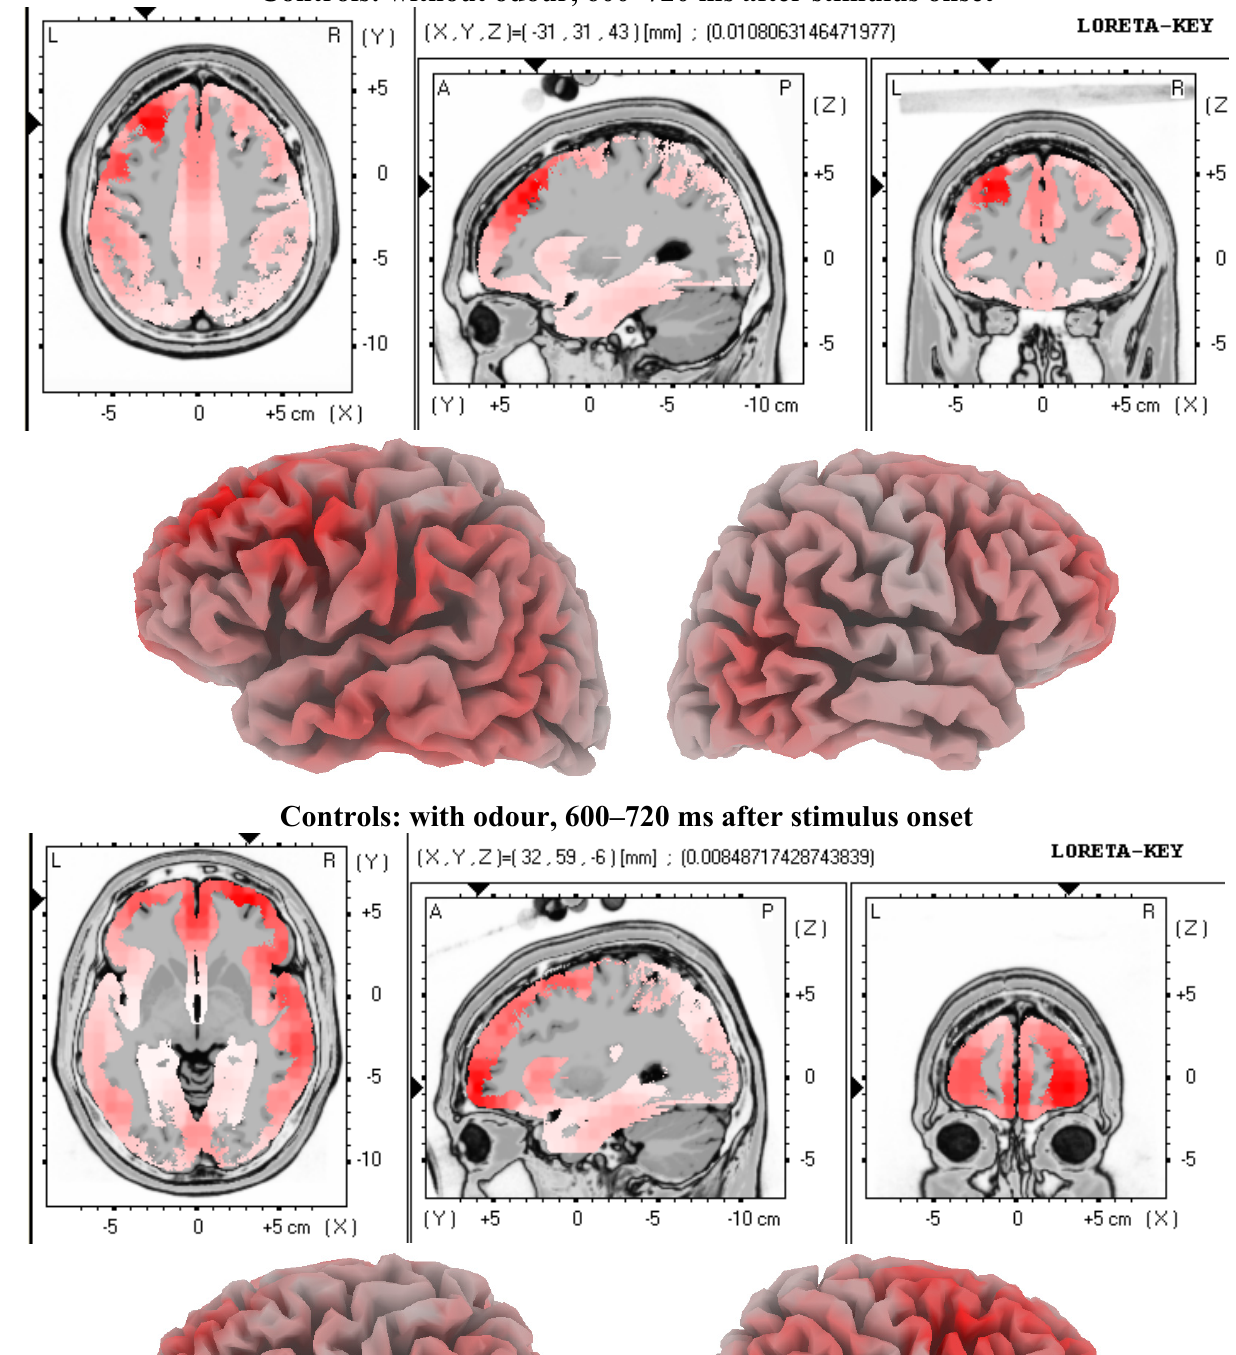
Figure 4. LORETA solutions for the late odour-related effect in controls. Maximum brain activity difference between odour versus no-odour can be seen at the right frontal area. Controls: without odour, 600–720 ms after stimulus onset